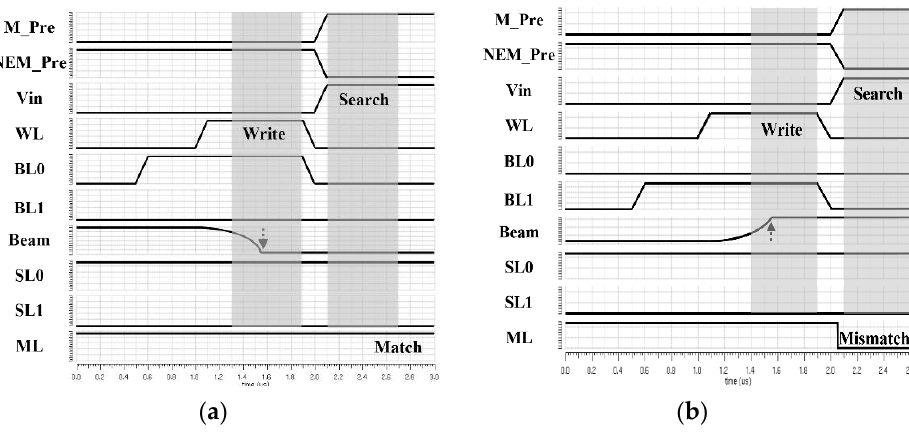
Figure 12. Pre-layout simulation of the single-bit NEM-based BCAM. ( a ) write 0, search 0, ‘match’; and ( b ) write 1, search 0, ‘mismatch’.